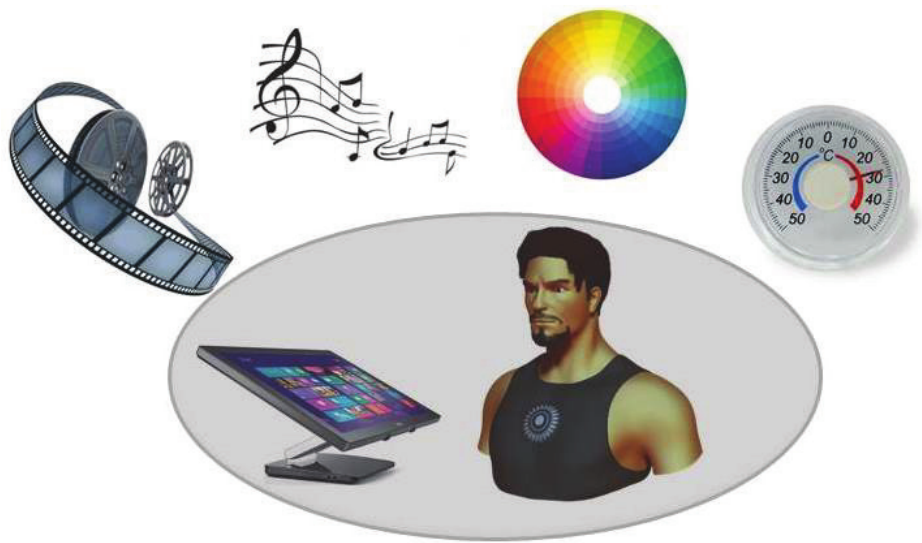
Figure 4. Environmental factors in affective